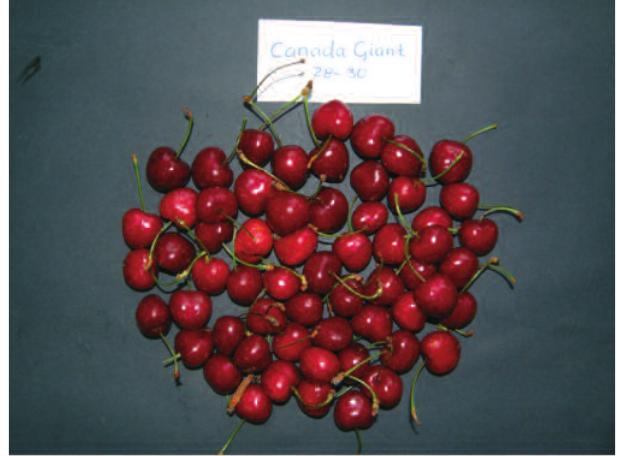
Fig. 15: The 28–32 mm size category of Canada Giant